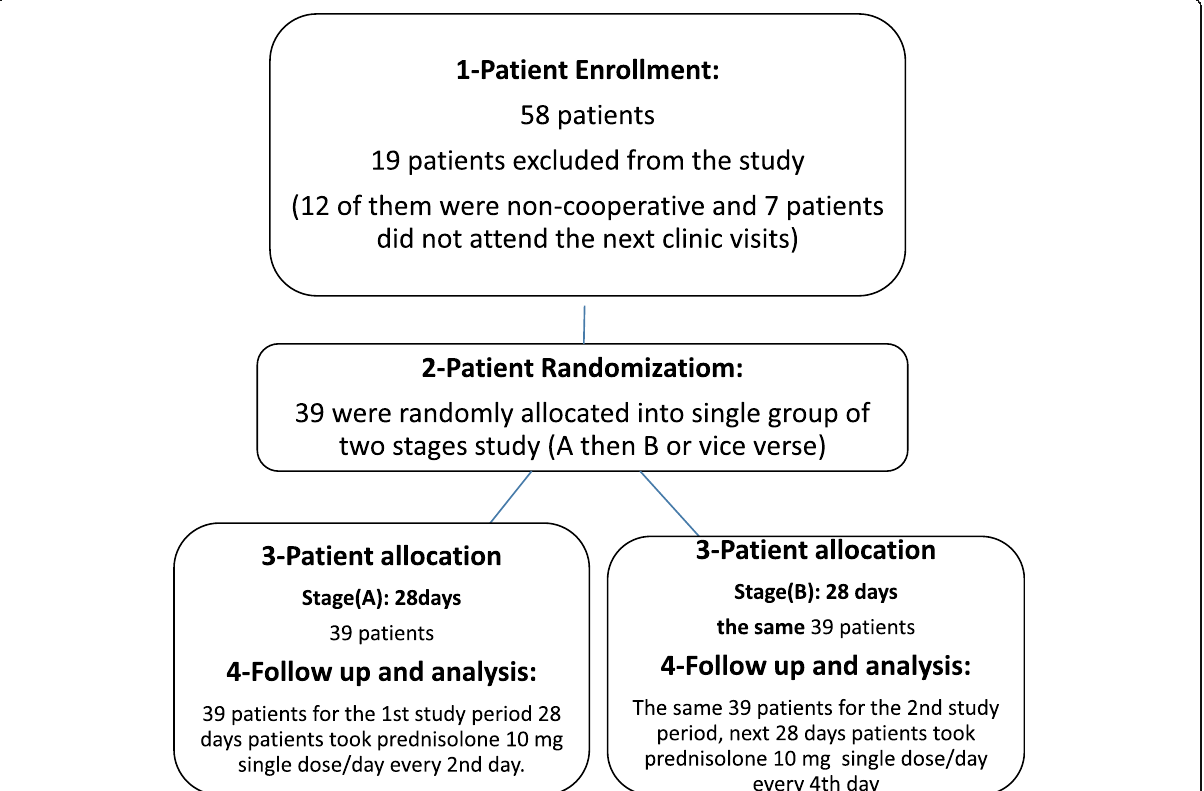
Fig. 2 Study flowchart. Enrolled patients were 58, Allocated patients were 39 patients into single group and 19 patients were excluded from the study (12 of them were non-cooperative and 7 patients did not attend the next clinic visits). Followed up and analyzed patients were 39 over two subsequent periods of analyses: 1st study period 28 days patients took prednisolone 10 mg single dose/day every 2nd day, then 2nd study period, next 28 days patients took prednisolone 10 mg single dose/day every 4th day with a washout period of 14 days in